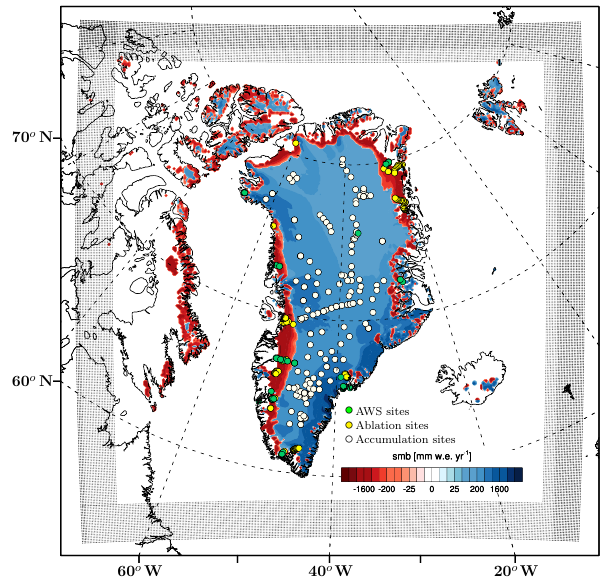
Figure 1. SMB (mmw.e.yr − 1 ) modelled by RACMO2.3p2 at 11km resolution for 2016. Black dots delineate the relaxation zone (24 grid cells) where the model is forced by ERA re-analyses. Ab- lation sites (213) are displayed as yellow dots, accumulation sites (182) as white dots, and AWS locations (23) are represented in